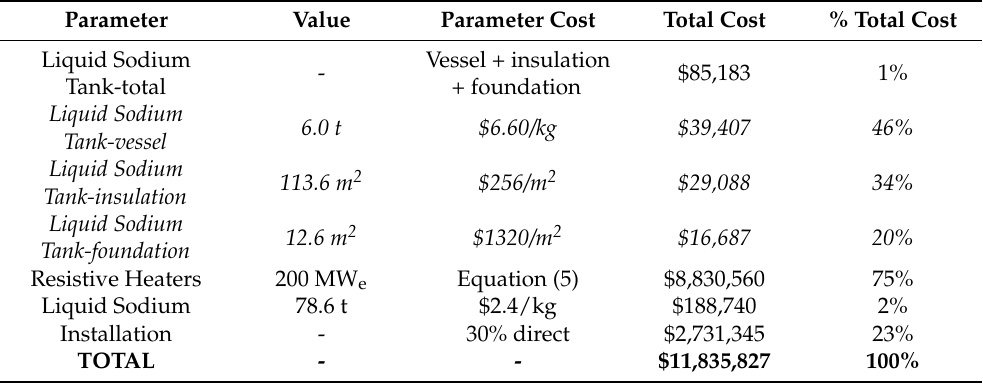
Table 5. Cost of Liquid Sodium Charge Tank